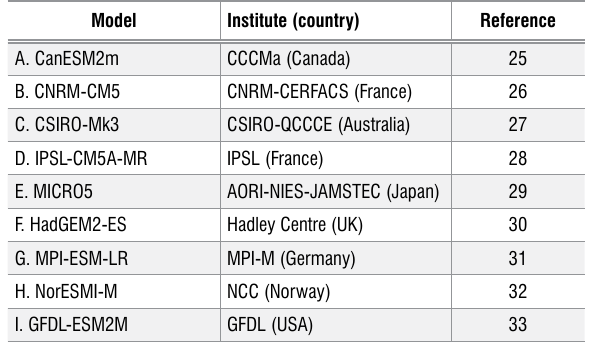
Nine Atmosphere-Ocean General Circulation Models used in this study for downscaling with the Rossby Centre Regional